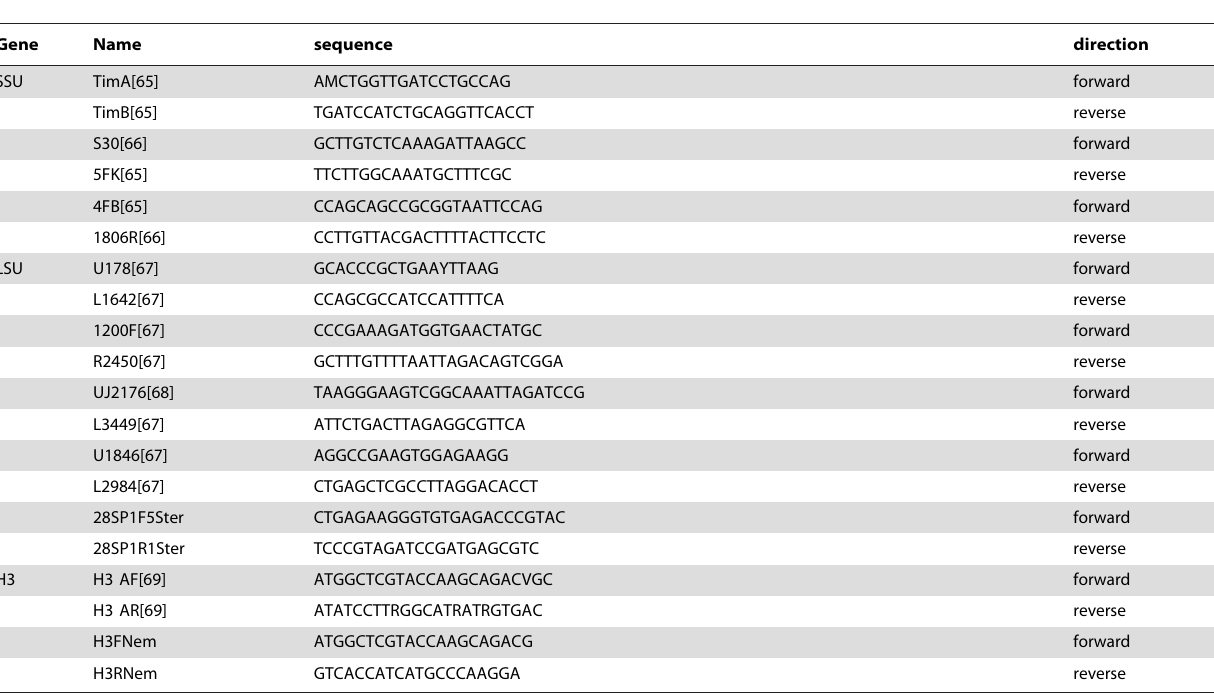
Table 3. Primers used in this study for sequencing of SSU, LSU and